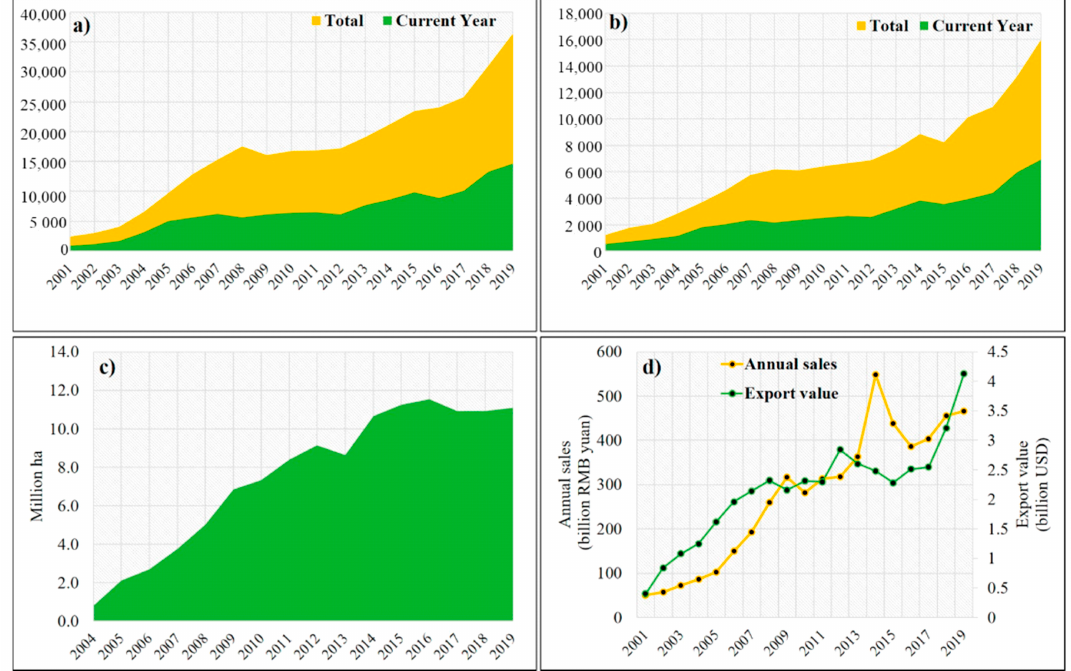
Figure 4. Green food development in China over the last two decades (2001–2019): ( a ) Number of certified products, ( b ) number of certified companies, ( c ) cultivated area, and ( d ) annual sales and export value. “Total” in ( a , b ) indicates cumulative number to date, and “Current year” refers to the number of newly certified products or companies in a particular